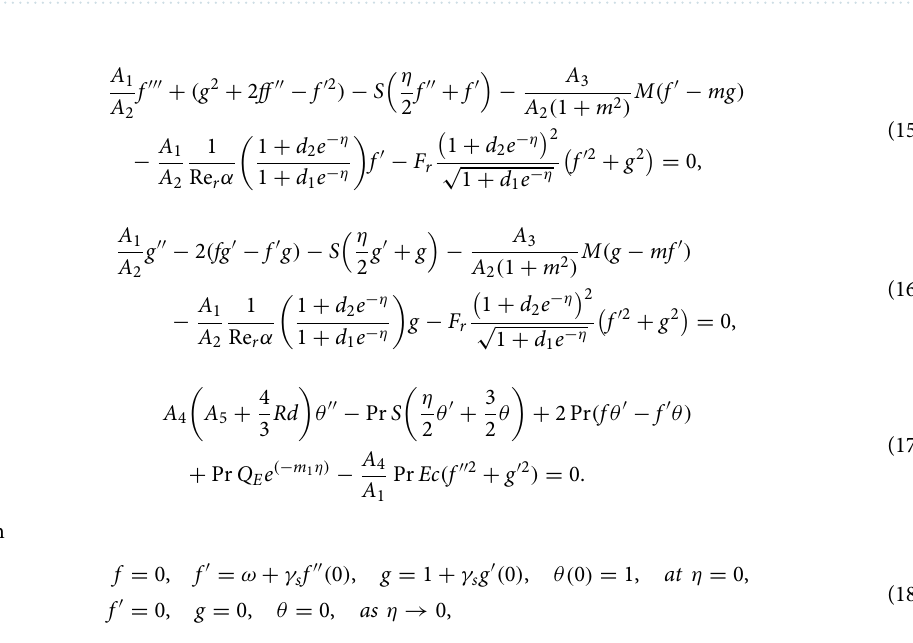
θ ′ ( 0 ) , g ′ ( 0 ) and f ′ ( 0 ) with 53,54 − −